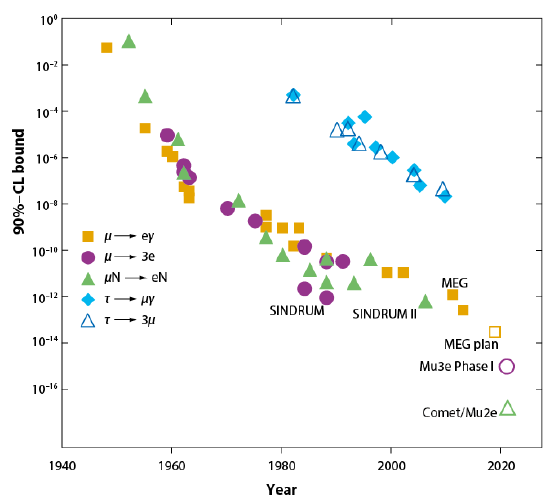
Figure 3: History of cLFV searches: evolution of upper bounds (90% C.L.) for cLFV processes set by various experiments over more than 60 years. The figure includes also sensitivity projections for the next generation of cLFV experiments, which are about to start taking data (Figure adapted from [ 3 ]